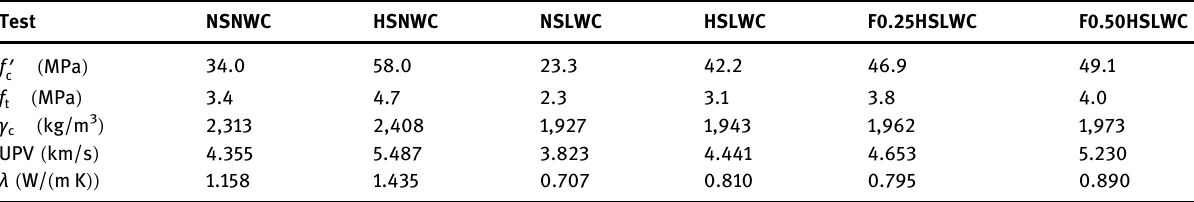
Table 3: Results of all concrete types ’ mechanical and physical properties